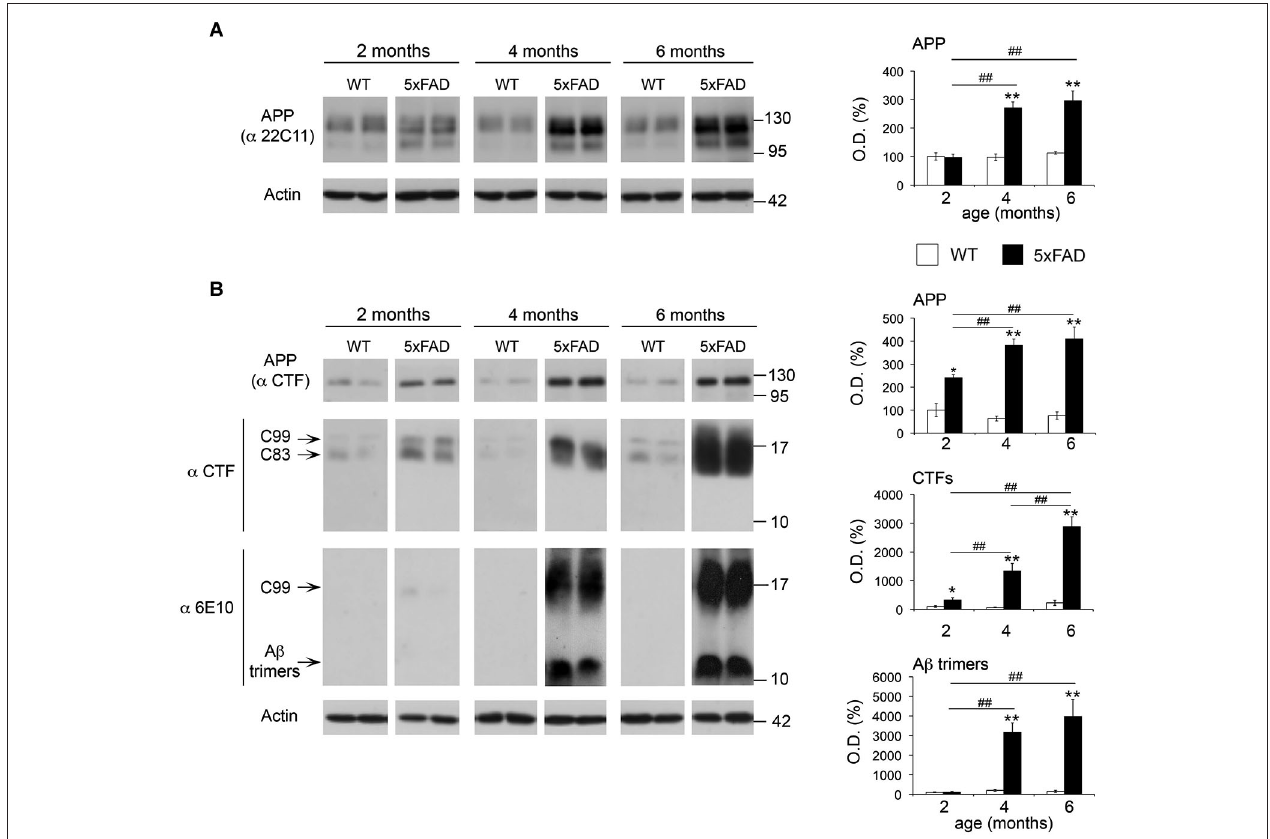
antibodies on membrane-enriched fractions of the same animals. Actin normalized values are the mean ± SEM of four mice per group representing the percentage of variation in optical density (O.D.). * p < 0.05, ** p < 0.01, when comparing 5xFAD vs . WT of the same age; # p < 0.05, ## p < 0.01, when comparing the same genotype across age; ANOVA followed by Tukey’s